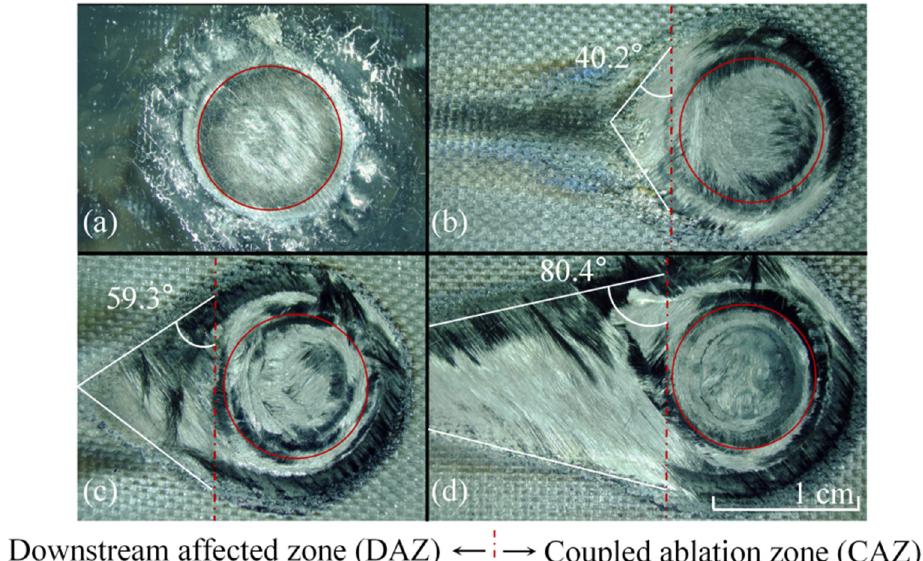
Figure 8. The laser ablation morphology in different condition. ( a ) Static air; ( b ) Ma 1.8, 1273 W/cm 2 ; ( c ) Ma 3.0, 1273 W/cm 2 ; ( d ) Ma 3.0, 2546 W/cm 2 .